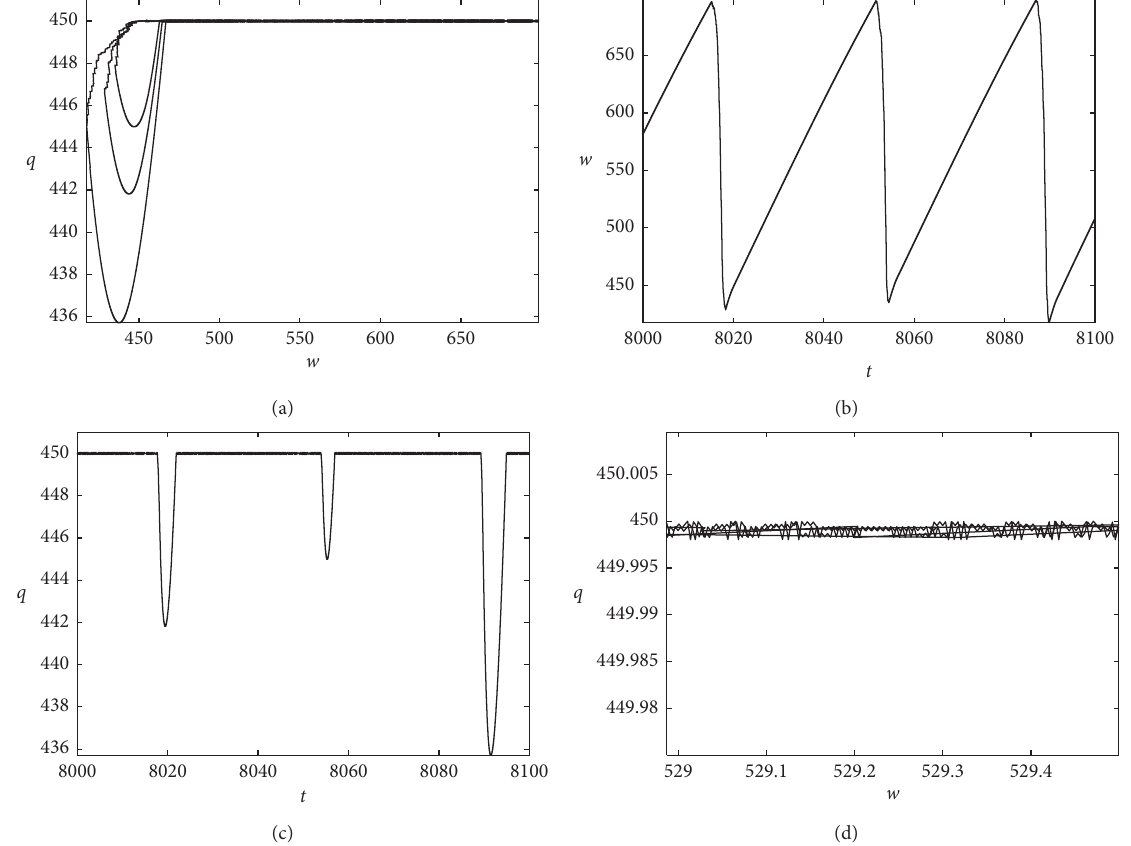
Figure 12: The chaotic oscillation with larger cycle-like part of system (10), where the phase portrait is in (a), time histories in (b) and (c), and (d) is the local magnification of the right part of (a).